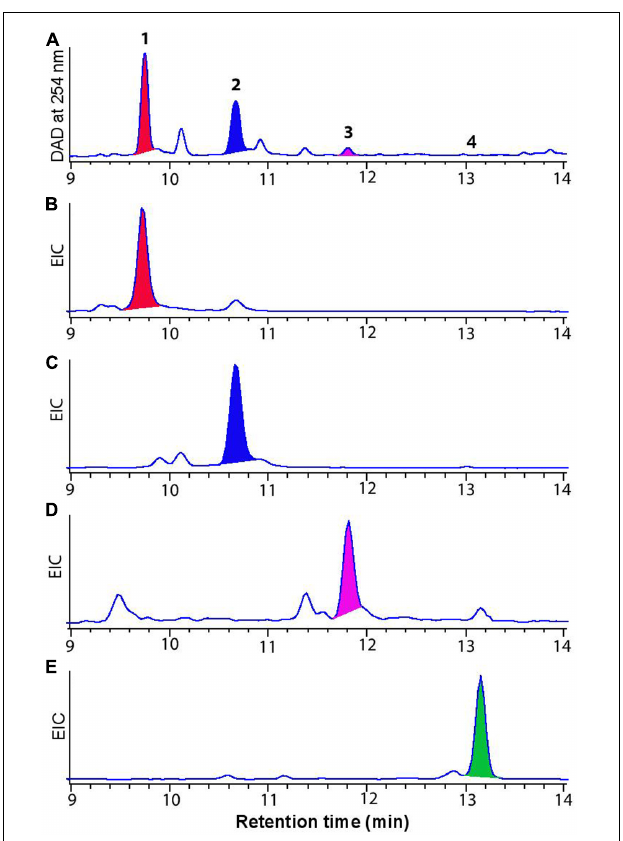
FIGURE 2 | (A) HPLC-DAD-MS (254 nm) chromatogram of cone snail-associated Streptomyces sp. extracts cultivated on ISP-4 agar (B) Single ion extraction (SIE) at m/z 511 [M-H]- corresponding to dehydromaltophilin (1) (C) at m/z 509 [M-H]- corresponding to 2 , (D) at m/z 493 [M-H]- corresponding to xanthobaccin (3) , and (E) at m/z 491 [M-H]- corresponding to FI-3 (4) .